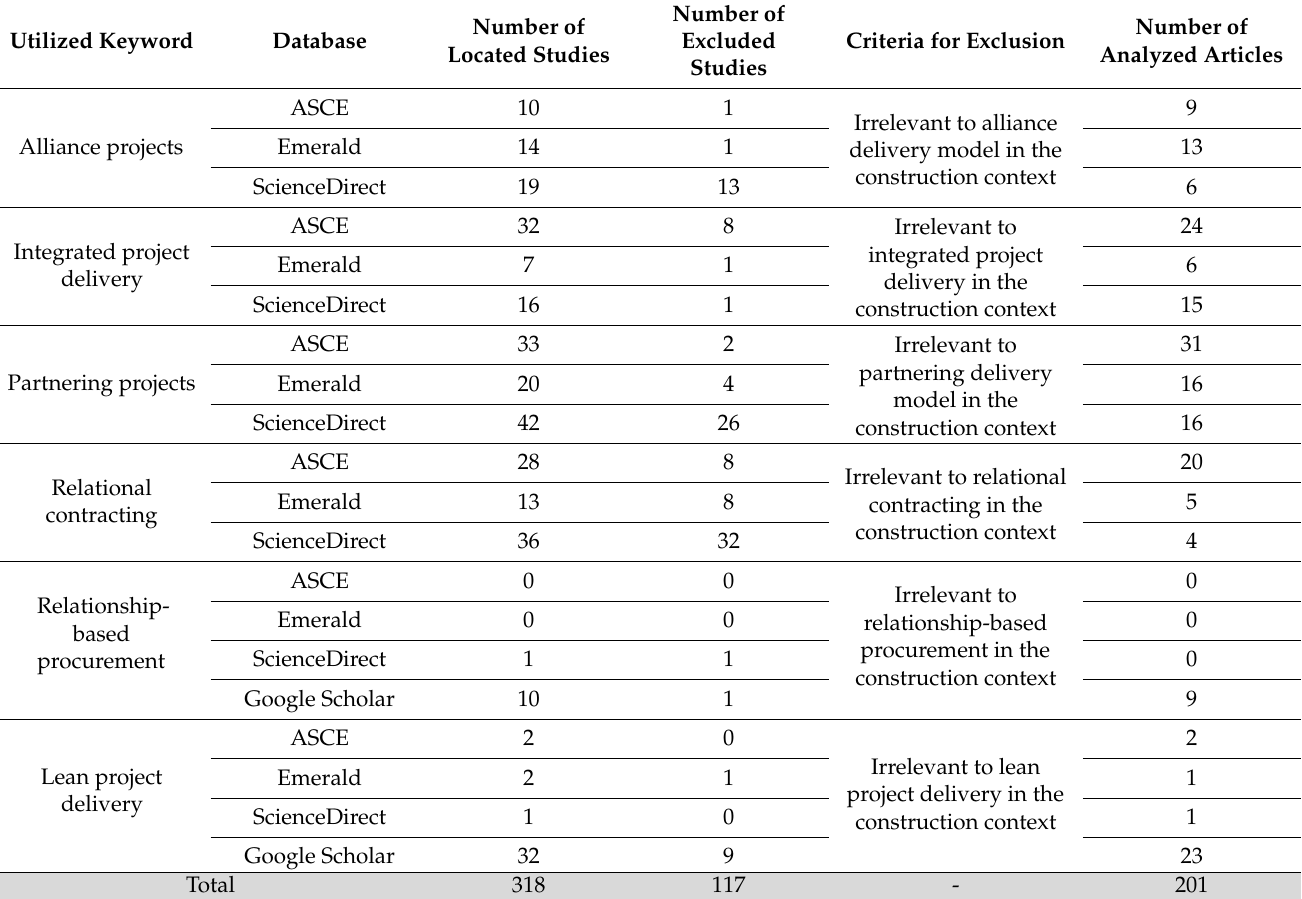
Table 3. Descriptive statistics of the search for relevant studies in the